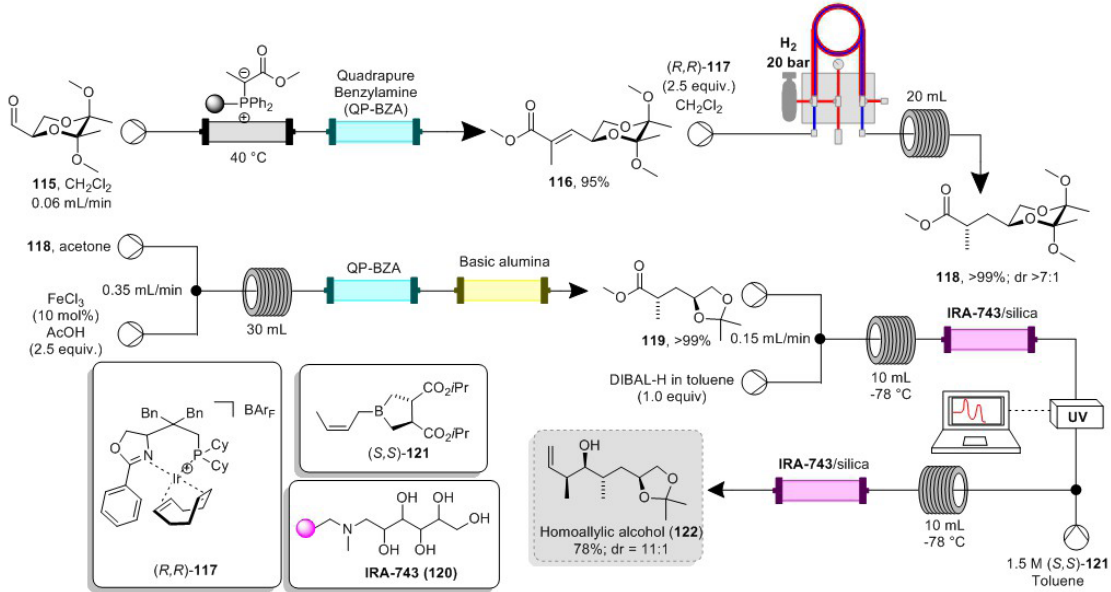
Scheme 30 - Continuous flow synthesis of the homoallylic alcohol 122